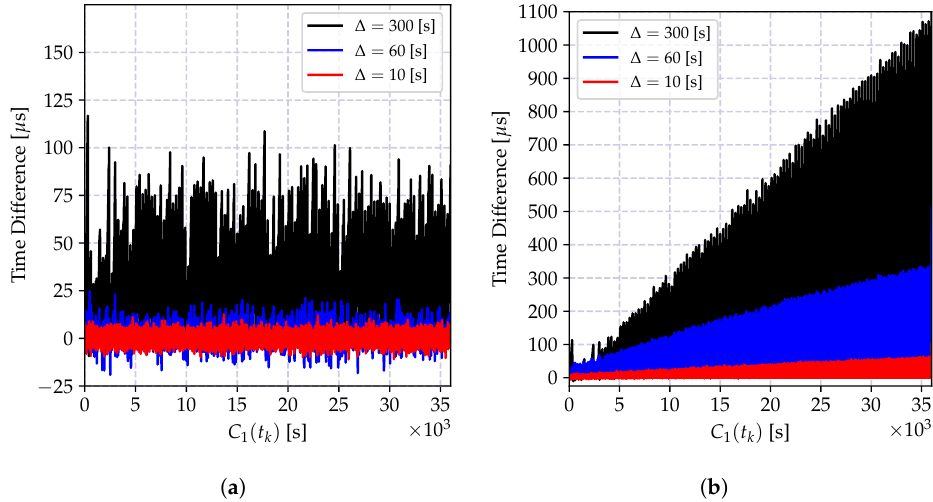
Figure 9. The time difference in microseconds between the local clock time reports and the reference clock reports when the time relation parameters of the incremental time model are estimated at different periods ∆ using different estimators. In ( a ), the least squares estimator using a regression table of N = 8 entries, and in ( b ), the recursive maximum likelihood estimator in Equation